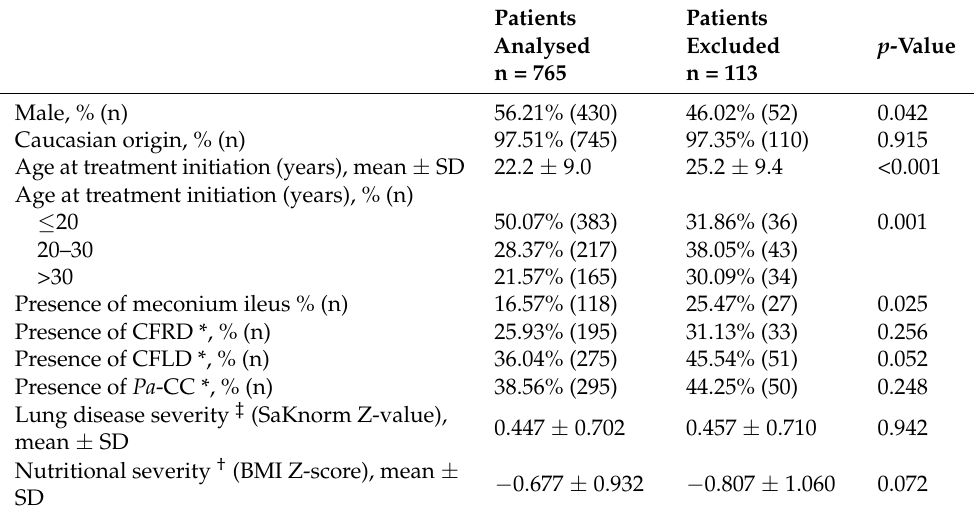
Table 1. Demographics and baseline (prior to combined lumacaftor/ivacaftor therapy) characteristics of the 878 eligible people with cystic